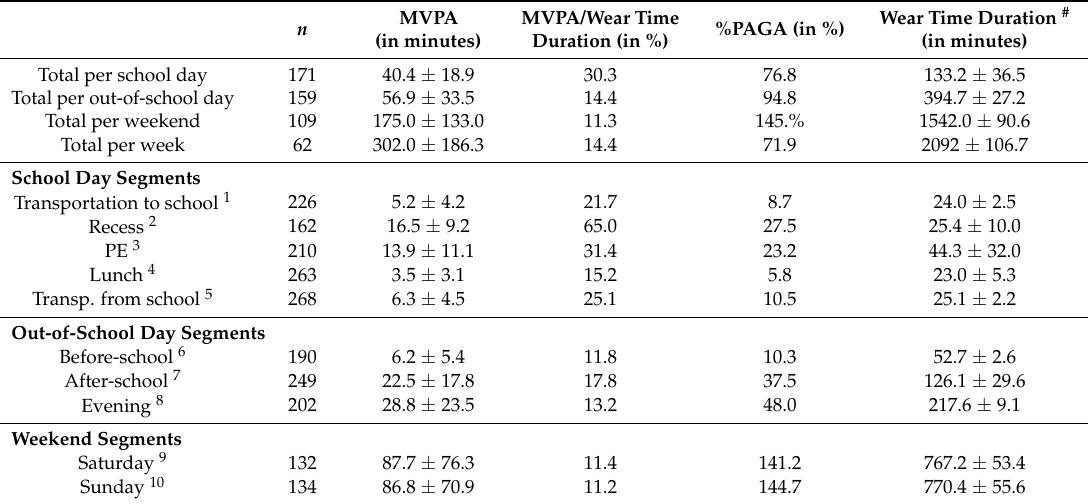
Table 1. Moderate-to-vigorous physical activity per day/session for school, out-of-school, weekend, and respective segmented windows of activity.